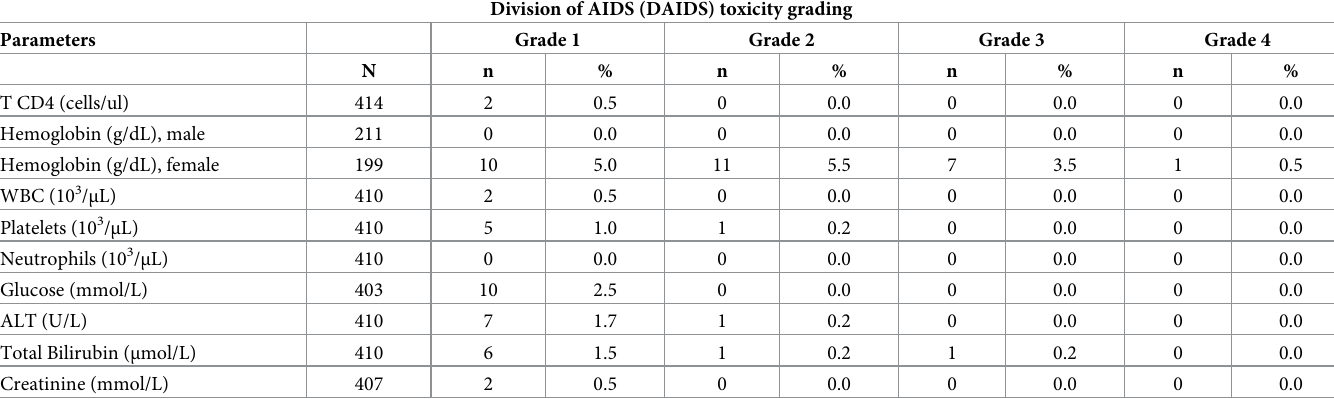
Table 7. Frequency of predicted adverse events from healthy adults at high-risk for HIV in Mozambique in comparison with values from DAIDS toxicity grading tables. Division of AIDS (DAIDS) toxicity